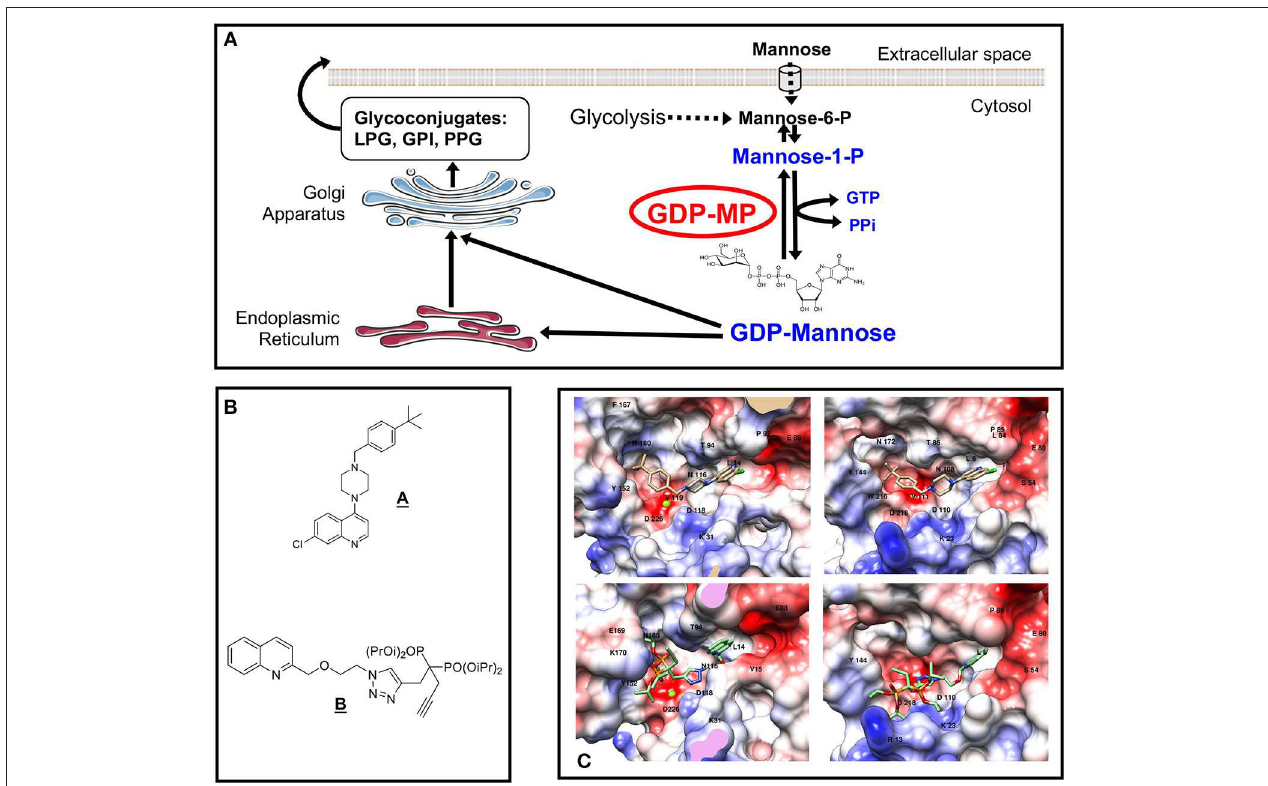
FIGURE 1 | Mannose activation pathways and GDP-MP inhibitors. (A) Mannose activation pathways and glycoconjugate biosynthesis in Leishmania . The GDP-MP substrates and products are indicated in blue. The GDP-MP is circled in red. (B) Chemical structures of compounds A,B . (C) Docking analyses of compound A (top) and B (bottom) in LdGDP-MP (left) and hGDP-MP (right) catalytic sites. The protein surface is colored as a function of the charge density: red, white, and blue colors indicating negative, neutral, and positive area, respectively. Magnesium ion is represented by a green sphere. The amino acids that make contact with compound A,B in the catalytic sites are indicated in their one-letter code and number in the sequence (Adapted from Daligaux et al., 2016a; Mao et al.,